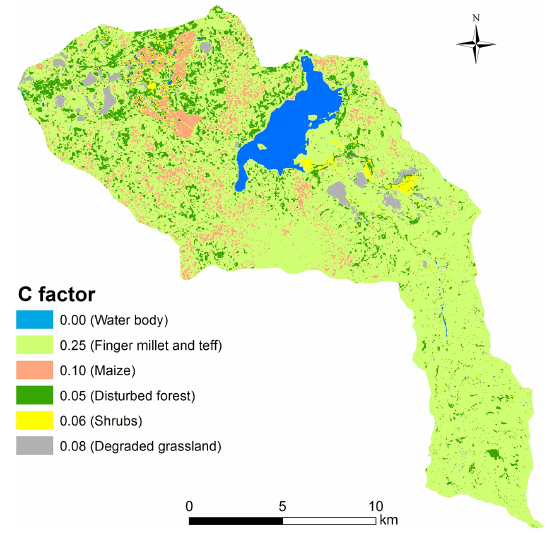
Figure 6. Map of C values quantified from land-cover classes based on different files of the Soil Conservation Research Program (SCRP) database and different SCRP publications (after Hurni, 1985; Wischmeier and Smith, 1978).